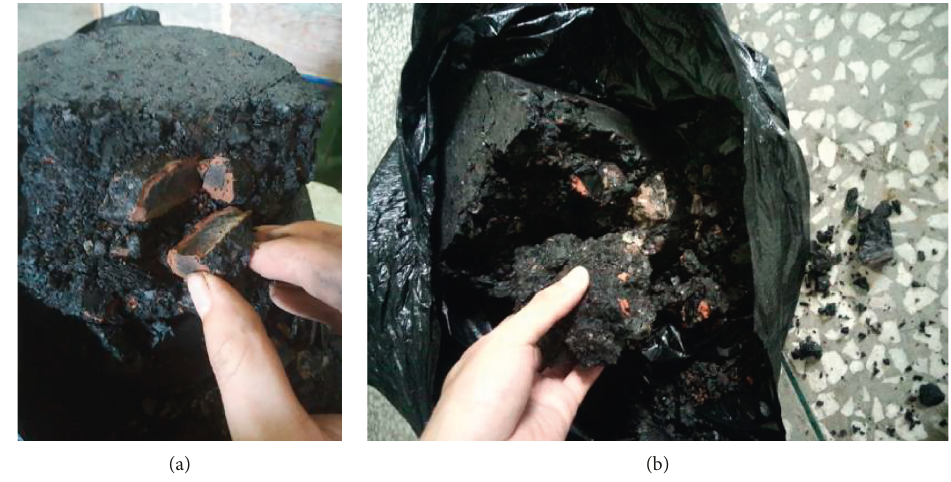
Figure 15: The internal cracking surfaces of samples: (a) FDS and (b)